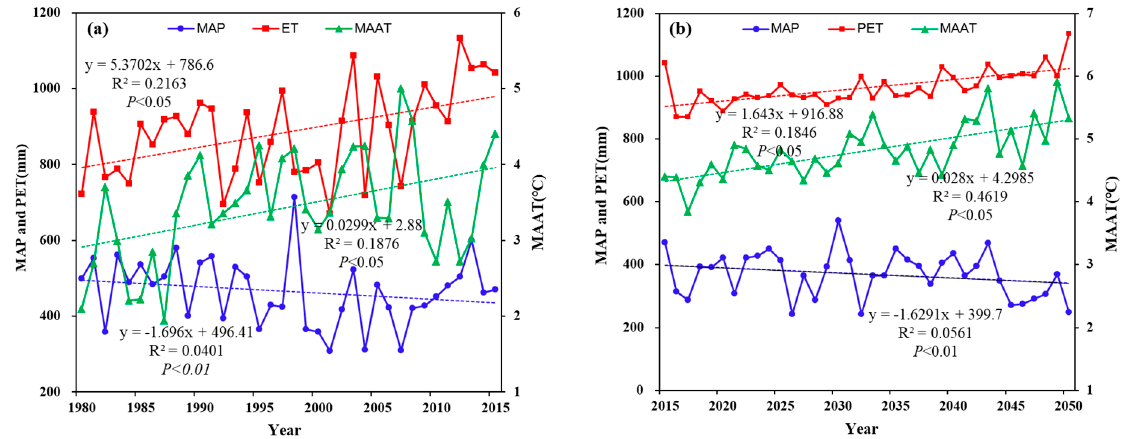
Figure 9. Past changes and future projections of climatic factors in the NJW. ( a ) Changes of mean annual air temperature (MAAT), mean annual precipitation (MAP), and evapotranspiration (ET) from 1980 to 2015 and ( b ) changes of future MAAT, MAP, and PET from 2015 to 2050.